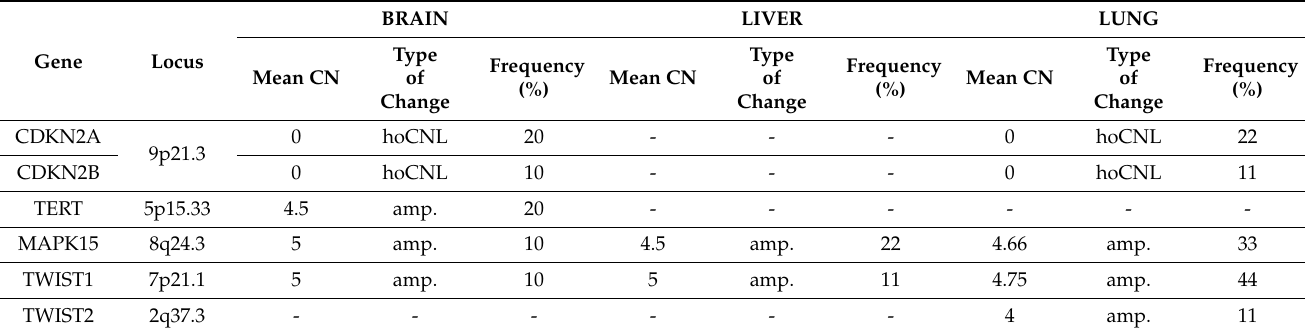
Table 2. Copy number changes of historical genes associated with the metastatic ability of malignant melanoma. Gene Locus